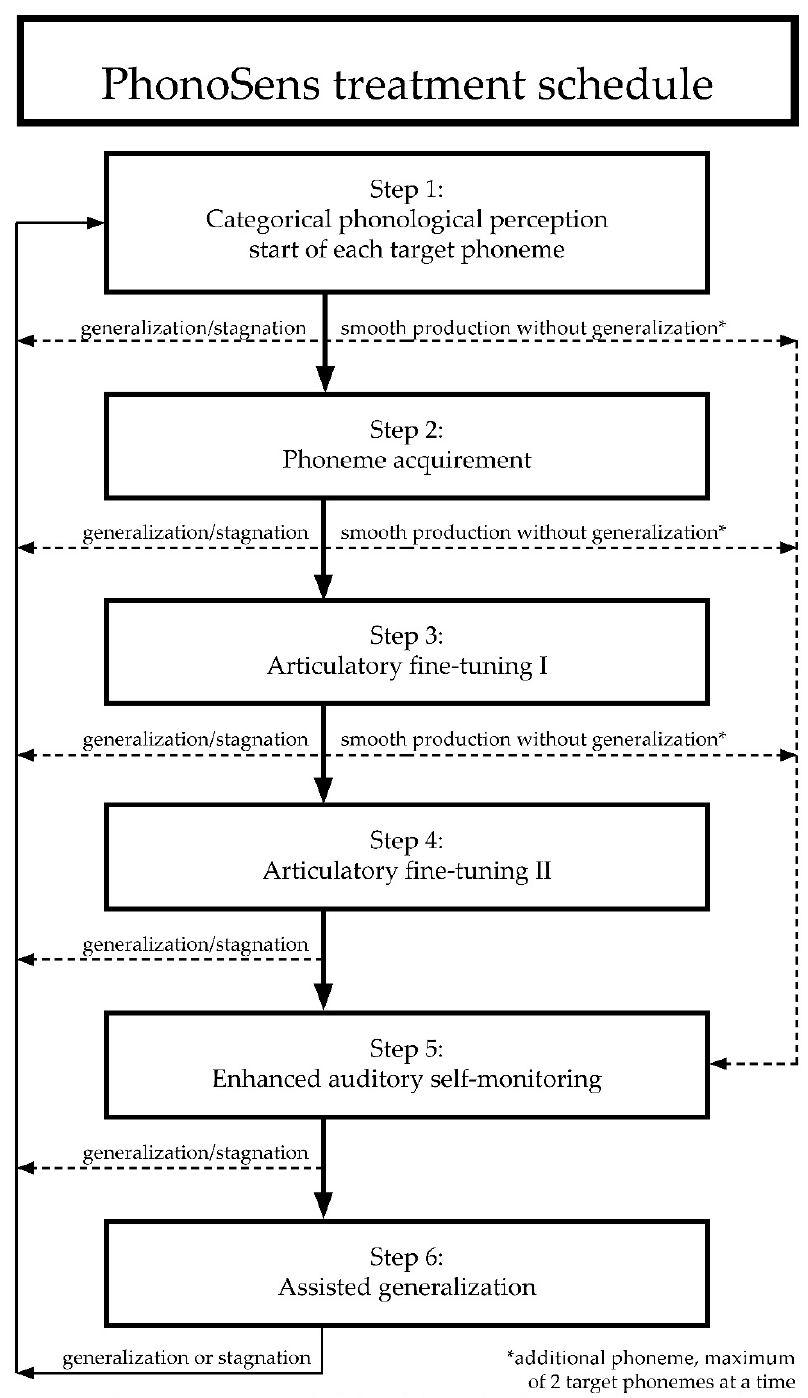
Figure 1. PhonoSens treatment schedule with hierarchical level and instruction for individual adaptation (dashed lines) over the course of a child’s treatment.